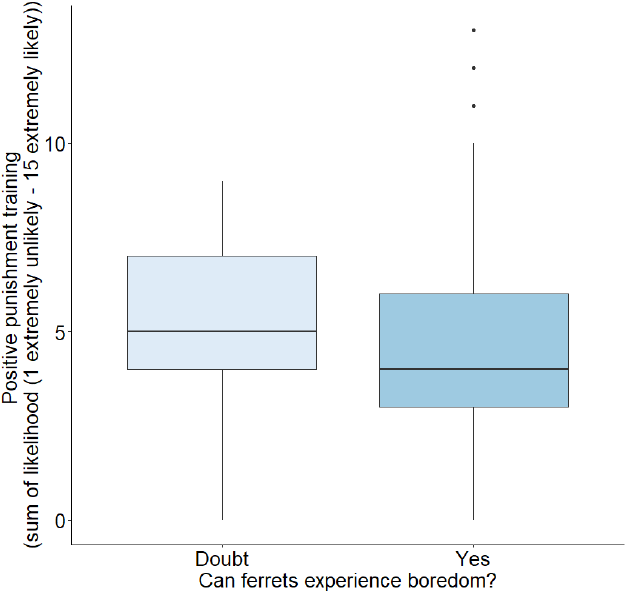
Figure 2. The likelihood of respondents who either doubted or believed that ferrets are able to experience boredom to use positive punishment-style training. The likelihood sum was taken from the answers to three Likert positive punishment training scenario questions, where respondents selected how likely they were to behave in the way detailed by the scenario, from ‘extremely likely’ through to ‘extremely unlikely’.